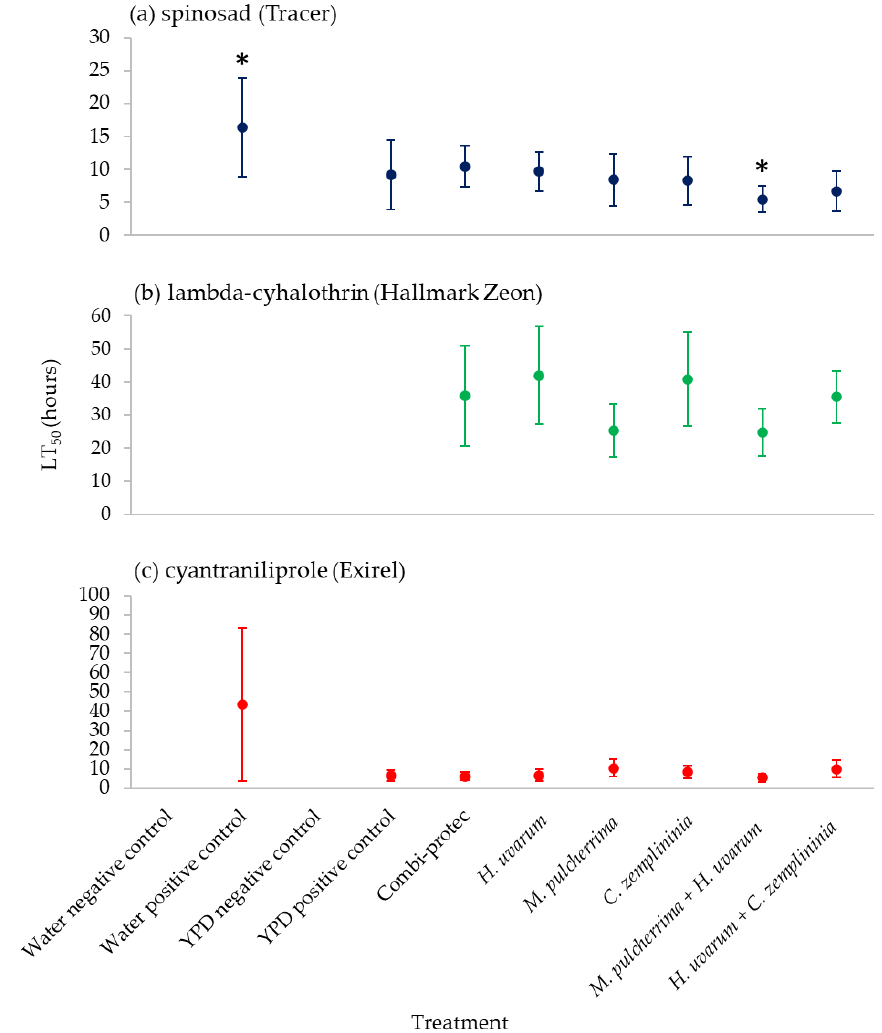
Figure 4. Median Lethal Time (time until death) of 50% (LT 50 ) of summer-morph D. suzukii